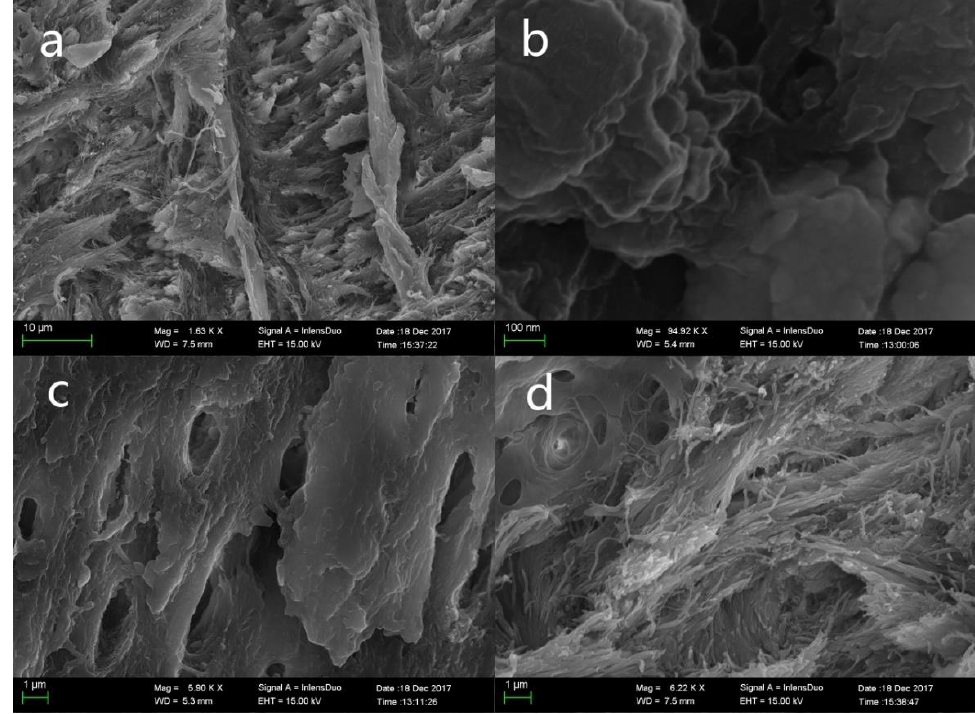
Figure 8. SEM images of the Retzius layer in ivory: ( a ) lamellar structure in radial plane (scale bar: 10 µm), ( b ) tabular hydroxyapatite in radial plane (scale bar: 100 nm), ( c ) tubules run from the central pulp to the periphery of the outmost layer in circumferential plane (scale bar: 2 µm), ( d ) collagen fibrils arranged along perpendicular to the long axes of the tubules in circumferential plane (scale bar: 2 µm).